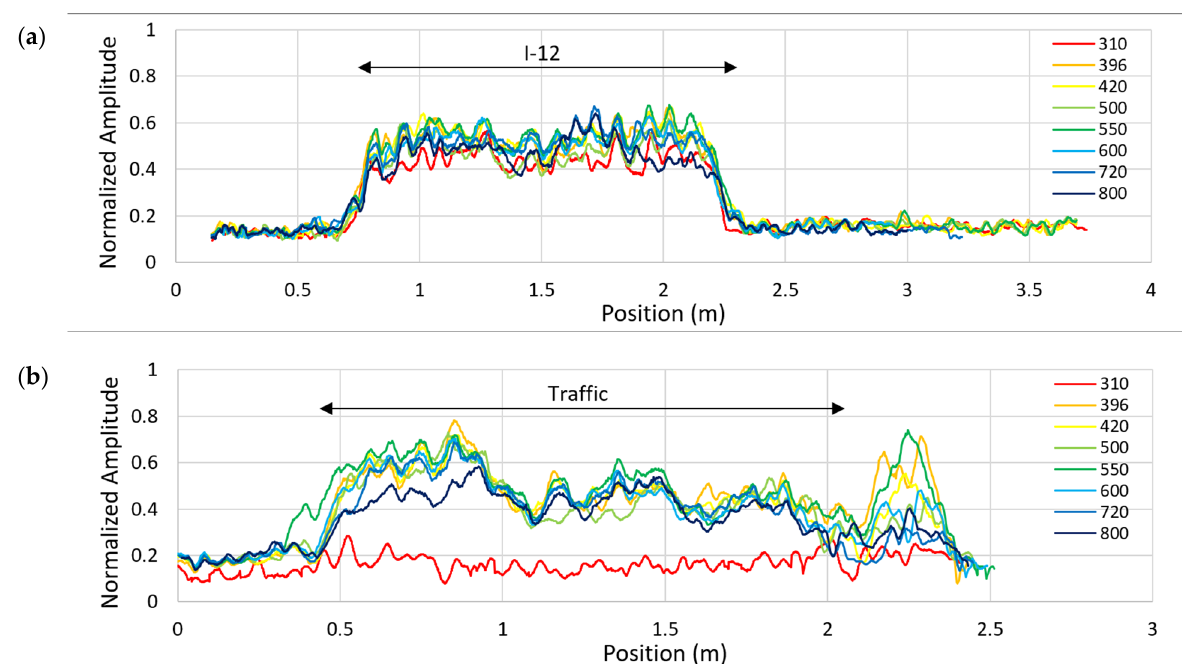
Figure 12. 2.6 GHz Norm. RW amplitudes on sand (I-11) in the ( a ) long. and ( b ) transv. direction vs. K loadings.